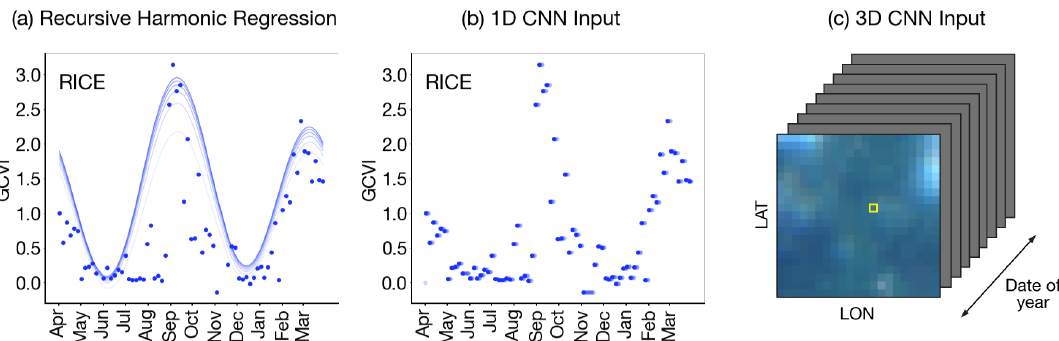
Figure 5. Feature extraction methods for Sentinel-2 time series. For the same example rice submission, ( a ) third-order harmonic regression with six recursive fits, ( b ) 1D convolutional neural network (CNN) time series input, and ( c ) 3D CNN time series schematic for an entire tile surrounding the submission are shown for the green chlorophyll vegetation index (GCVI) band. In ( b , c ), days without a Sentinel-2 image are filled in with the most recent previous image. In ( c ), the yellow box encircles the labeled submission pixel; all other pixels are